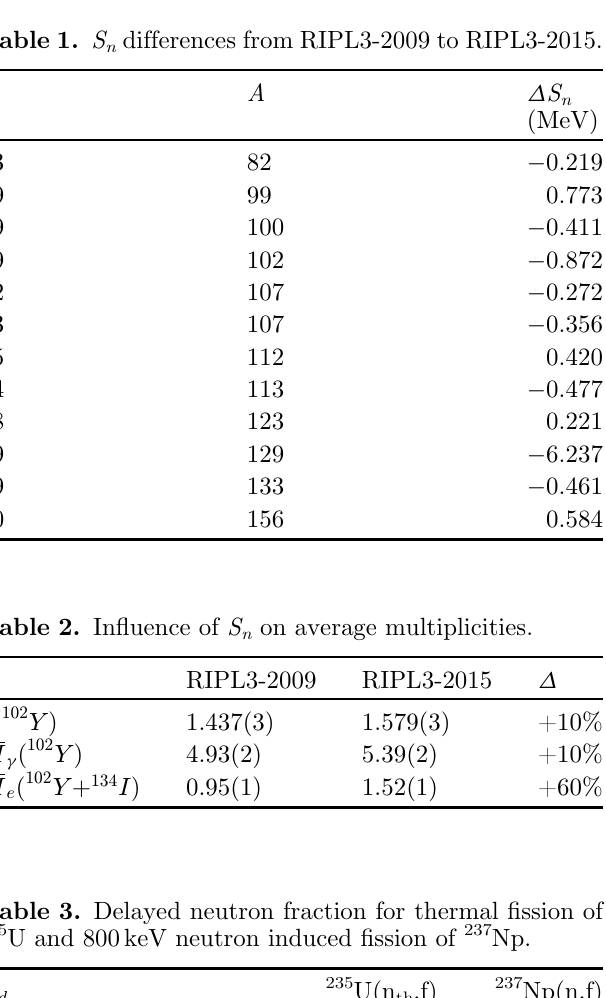
Fig. 4. In fl uence of the half-life of levels on the average prompt fi ssion gamma multiplicity as function of pre-neutron fragment mass.